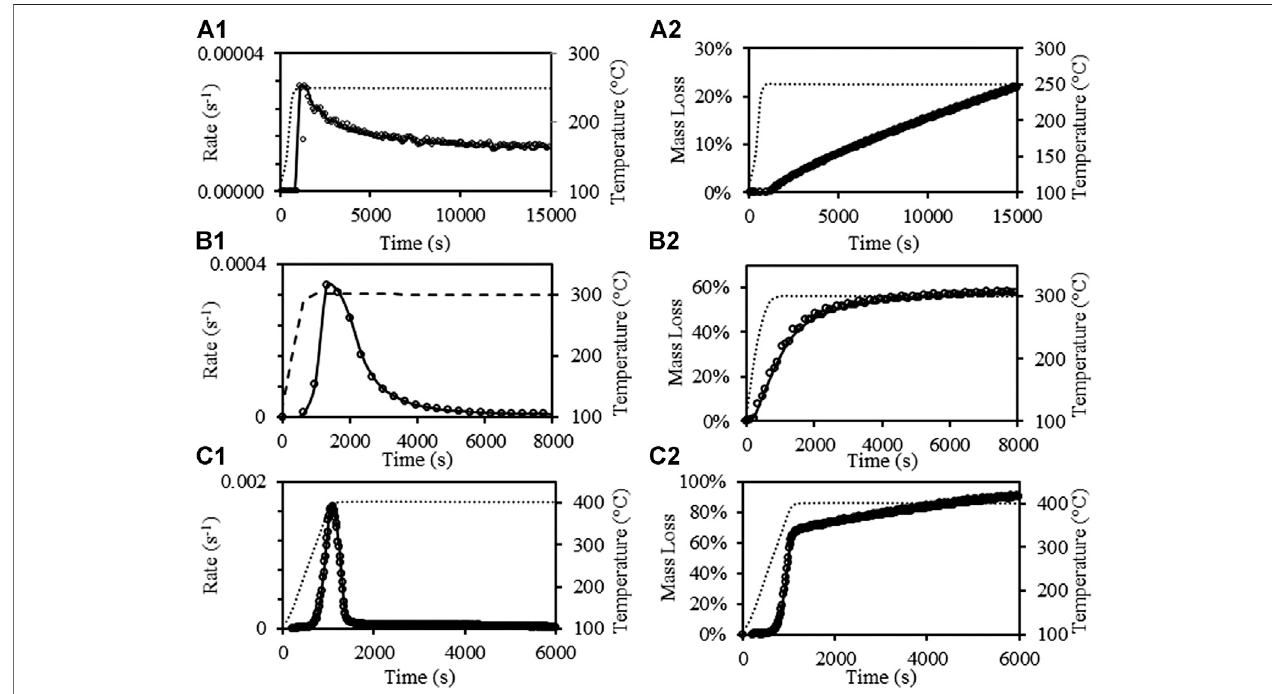
FIGURE 2 | Mass loss rate of paper wastes torrefaction at: 250 ° C (a1) , 300 ° C (b1) , 400 ° C (c1) ; mass loss of paper torrefaction at: 250 ° C (a2) , 300 ° C (b2) , 400 ° C (c2) .